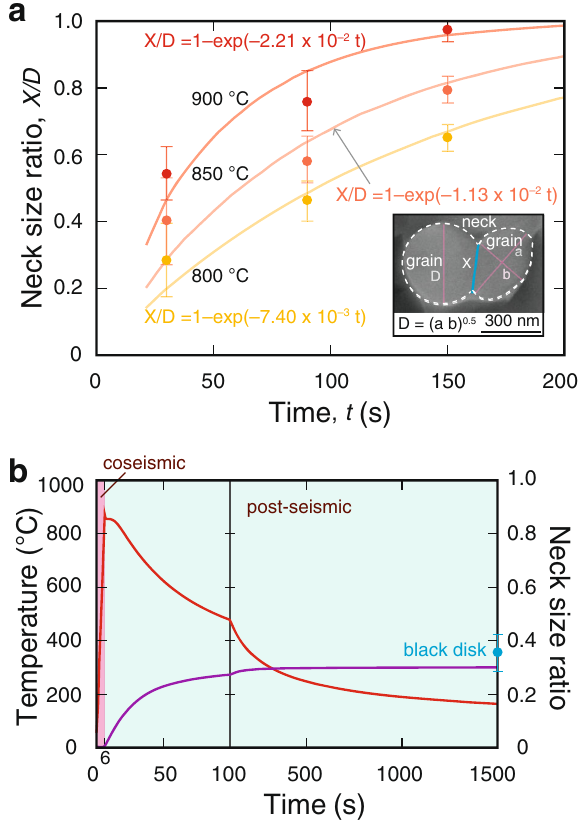
Fig. 4 Neck growth kinetics during heating and simulation of neck growth during an earthquake. a Changes in the neck-size ratio ( X / D ) with heating duration. b Simulation of neck growth during coseismic and post-seismic phases based on the temperature – time pro fi le (red curve) for the 1999 Chi- Chi earthquake. Error bars indicate standard deviations from the mean values. The purple curve shows the evolution of the neck-size